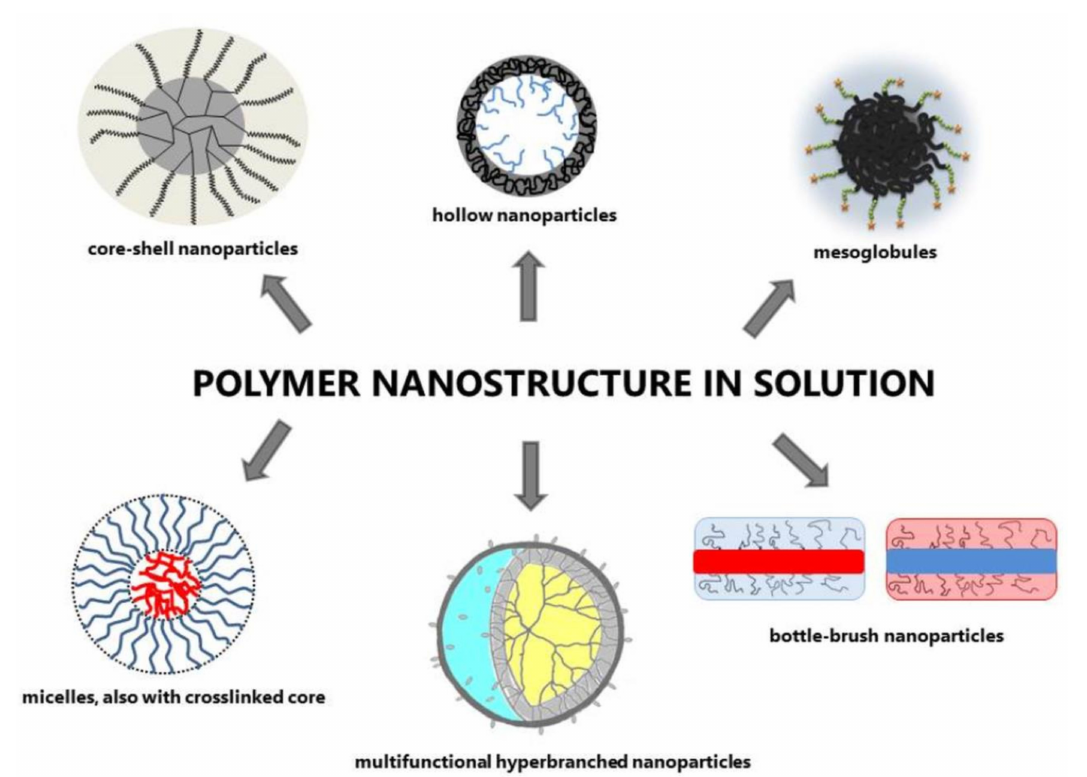
Figure 2. Schematic representation of the polymeric nanostructures in solution obtained in the Laboratory of Nano- and Microstructural Materials of CMPW PAS.